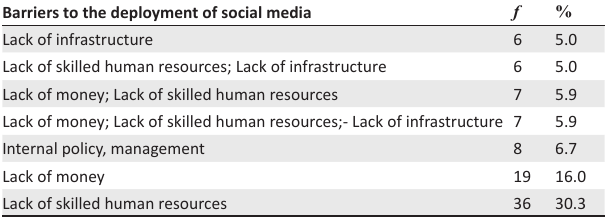
TABLE 4: Barriers to deploying social